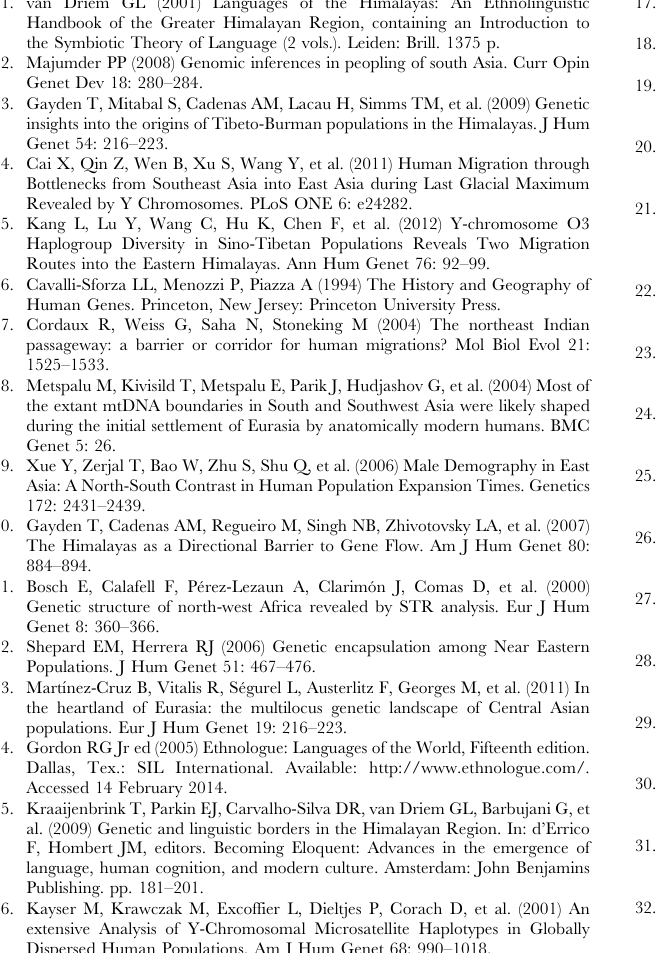
(2007) Allele frequency distribution for 21 autosomal STR loci in Nepal. Forensic Sci Int 168: